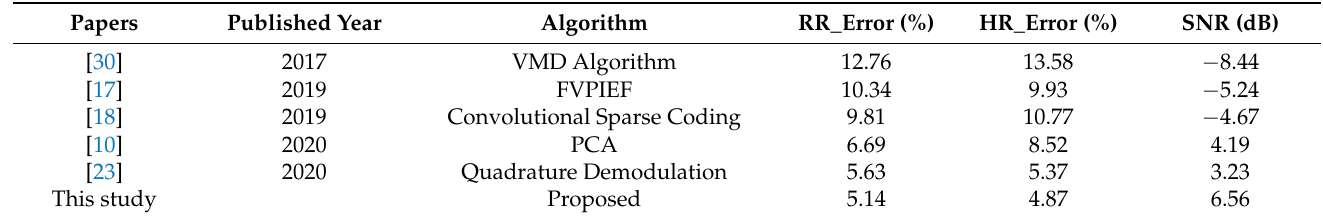
Table 4. Errors and signal − to − noise ratios of different algorithms for estimating vital signs